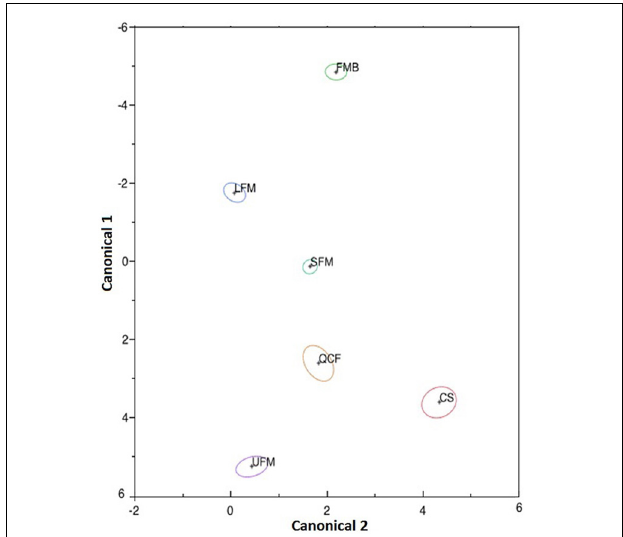
FIGURE 2 | Plot of the first two canonicals, which together explain 90.8% of the variation in the data, for each call. Each point represents the centroid for a given call type. Ellipses show the 95% confidence interval around each centroid. See Table 2 for standardized coefficients that indicate how the call parameters contribute to canonical 1 and 2. Overall, 95% of calls were correctly classified to type. Call type abbreviations: UFM, upward frequency-modulated;CS, chevron-shaped; SFM, short frequency-modulated;LFM, long frequency-modulated;QCF, quasi-constant frequency; and FMB, frequency-modulatedbout.